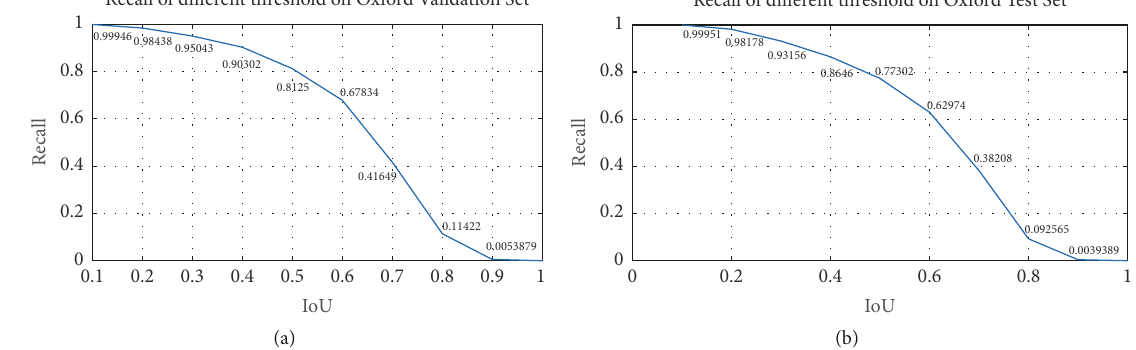
Figure 5: Recall of Edgeboxes algorithm on the Oxford dataset: (a) validation set; (b) test set.